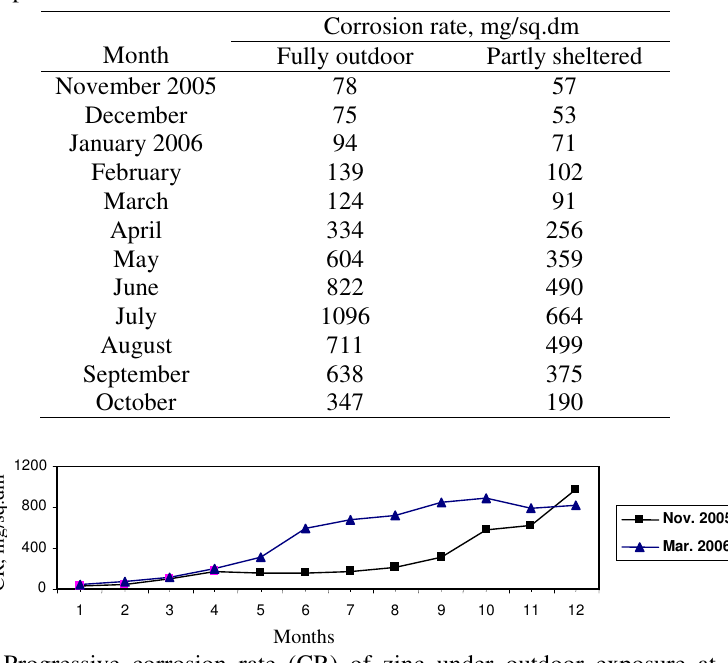
Table 1. Corrosion rate of mild steel in fully outdoor and partly sheltered condition at an urban atmosphere.